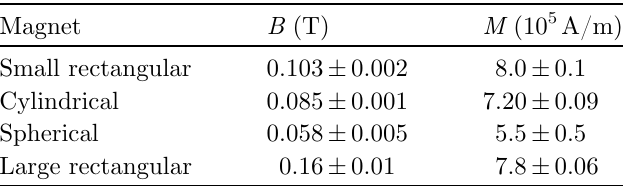
Table 2. The magnetic fi eld B that was measured for each magnet at a distance of 0.5 cm from its surface, as well as the magnetization M that was calculated from it.